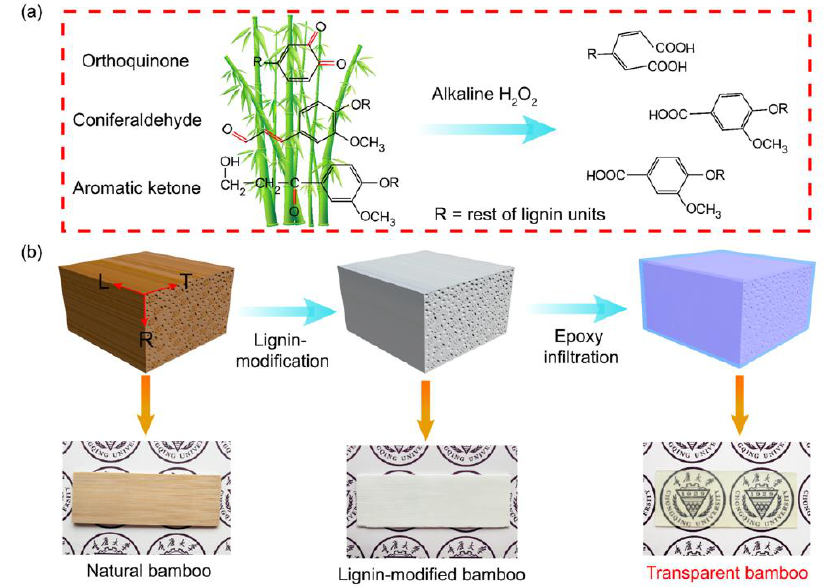
Figure 10. Lignin modification in bamboo moso ( a ) and process of obtaining TB by epoxy infiltration ( b ). Reprinted with permission from [35], copyright 2022, Elsevier.